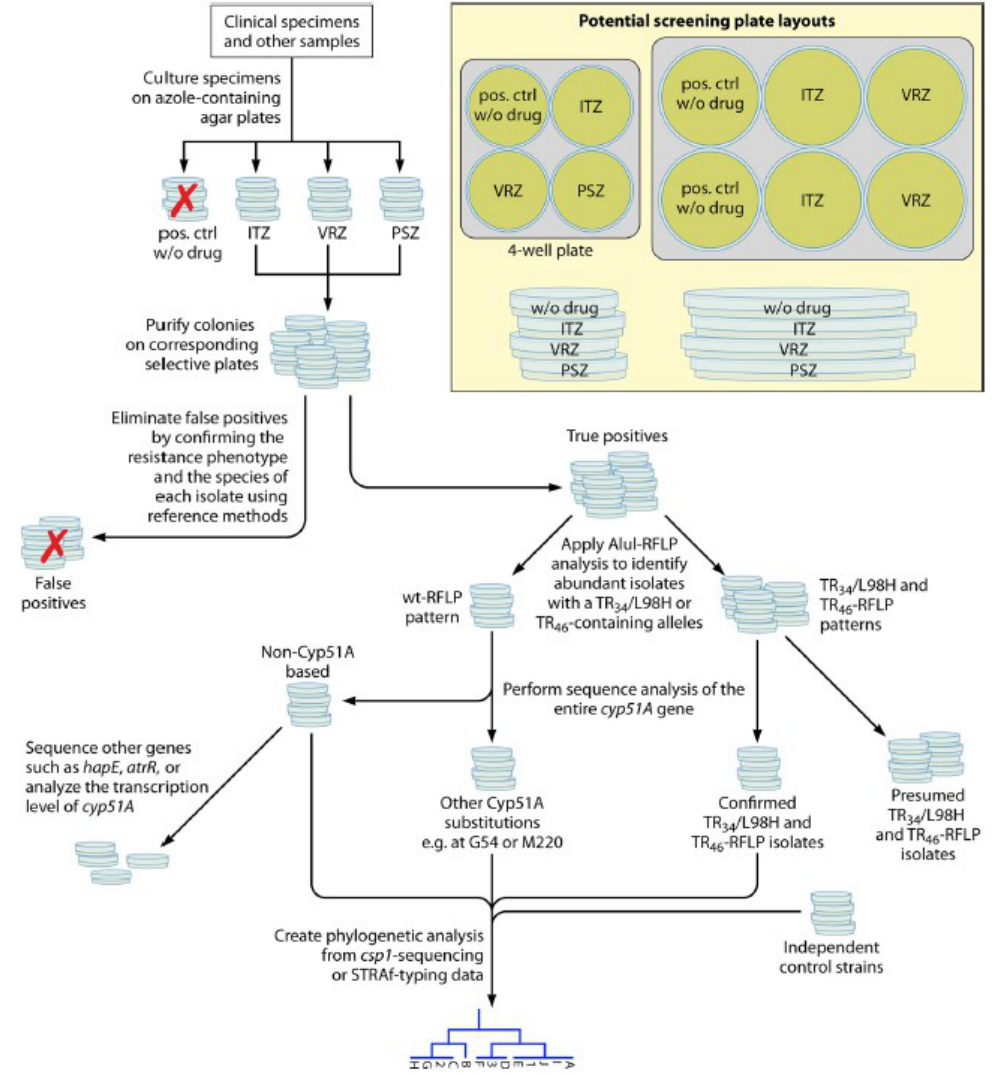
Figure 2. Potential screening of azole-resistant A. fumigatus isolates. Shown is a stepwise workflow that eliminates false-positive results (indicated by a red X) and can be helpful to build up local epidemiological data on the prevalence and phylogenetic linkage of resistant isolates. In this figure, true positives are derived from the growth of isolates on selective agar plates containing drug concentrations that range from 0.5 µ g/mL for posaconazole (PSZ) to 1 to 4 µ g/mL for itraconazole (ITZ) or voriconazole (VRZ). Then, isolates are identified at the species level by multilocus DNA sequencing [46] (got permission to use).